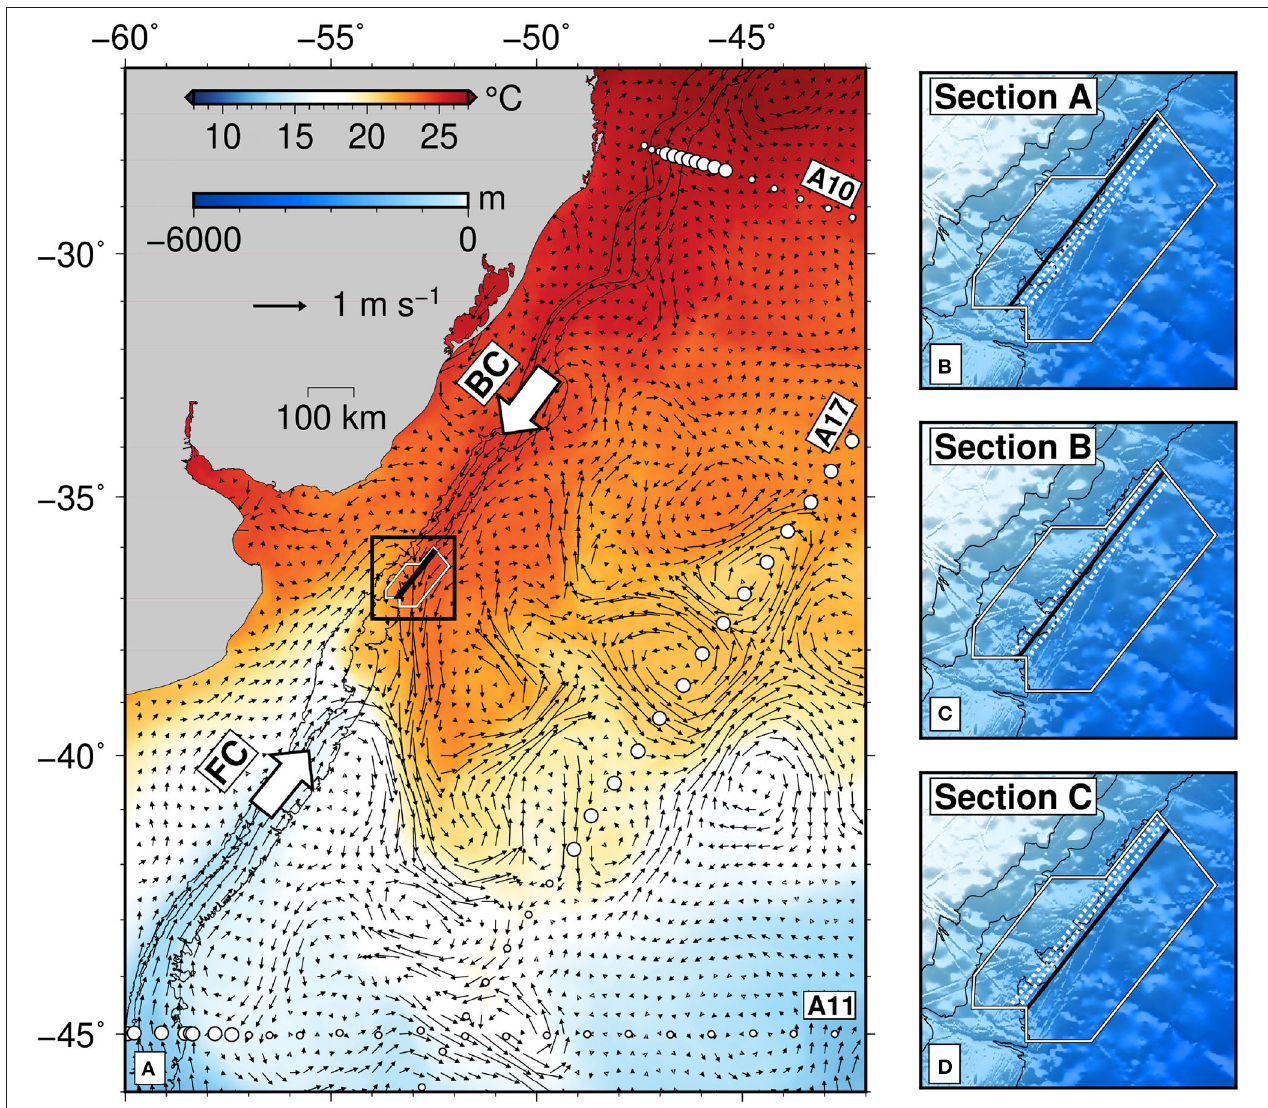
FIGURE 1 | (A) Map of southwest Atlantic Ocean where red/blue colors represent warm/cold mean sea-surface temperatures for monthly composite centered on 16th February 2013 (taken from Multi-scale Ultra-high resolution (MUR) satellite sea-surface temperature measurements which have monthly and 1 km resolution). Thin black lines = 300/1,000/2,000 m bathymetric contours; field of black arrows = average sea surface geostrophic current velocities calculated for 5-day composite centered on 15 February 2013 from OSCAR satellite measurements (scale at top left-hand side); labeled arrows 0 = 0Brazil Current (BC) and Falkland (i.e., Malvinas) Current (FC); black box = zoom region shown in panels (B–D) ; white polygon 0 = 0location of 3D seismic reflection survey; thick black line within polygon 0 = 0locus of three transects displayed in Figures 4 – 9 ; small white circles = loci of conductivity temperature depth (CTD) probes acquired as part of GO-SHIP transects A10 (December 1992), A17 (April 2019) and A11 (December 1992); large white circles = loci of CTDs used to compute average hydrographic profiles ( Figure 2 ). (B–D) Zoomed portion shown in (A) . Blue shading = water depth according to scale bar at top left-hand of (A) ; thin black lines = 300/1,000/2,000 m bathymetric contours; white polygon 0 = 0location of 3D seismic reflection survey; solid black line inside polygon = seismic transect acquired on given date; dotted white lines 0 = 0other transects.